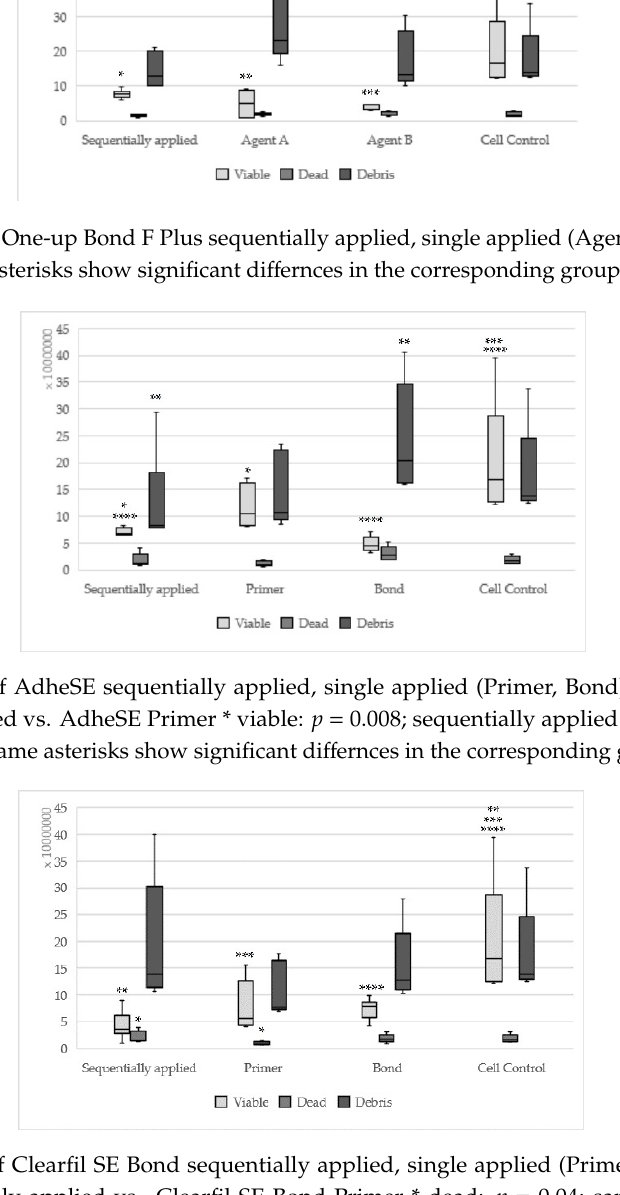
Figure 5. Results of Clearfil SE Bond sequentially applied, single applied (Primer, Bond) and Cell control; (Sequentially applied vs. Clearfil SE Bond Primer * dead: p = 0.04; same asterisks show significant differnces in the corresponding groups).